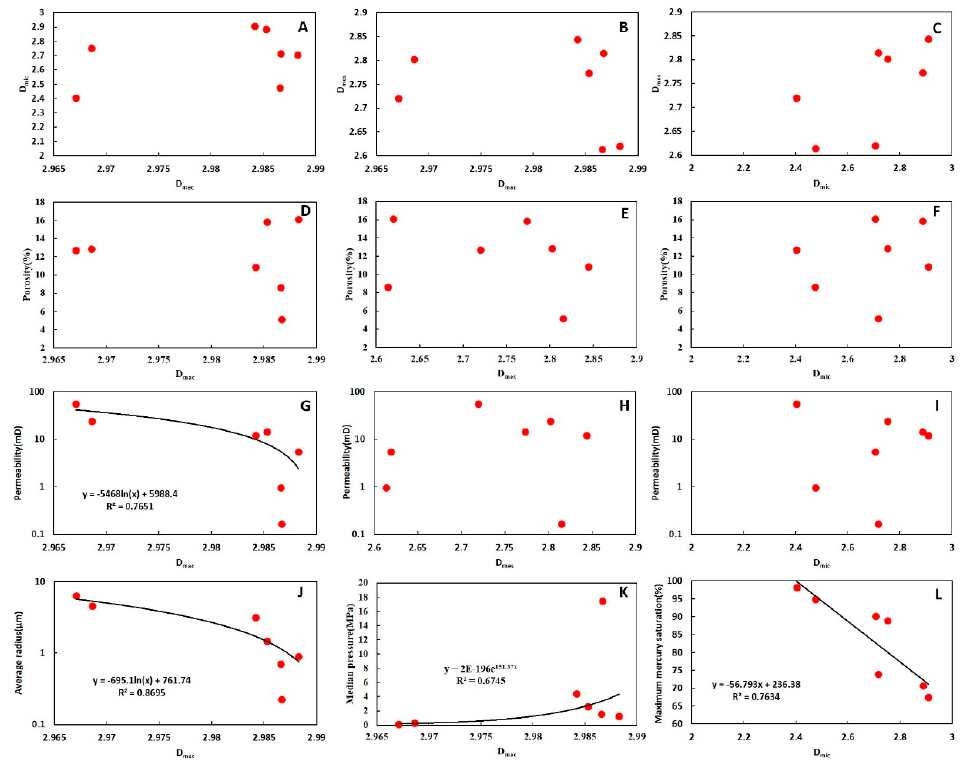
Figure 17. Plot showing the relationships between ( A ) D mac and D mic ; ( B ) D mac and D mes ; ( C ) D mes and D mic ; ( D ) Porosity and D mac ; ( E ) Porosity and D mes ; ( F ) Porosity and D mic ; ( G ) Permeability and D mac ; ( H ) Permeability and D mes ; ( I ) Permeability and D mic ; ( J ) Average radius and D mac ; ( K ) Median pressure and D mac ; ( L ) Maximum mercury saturation and D mic .